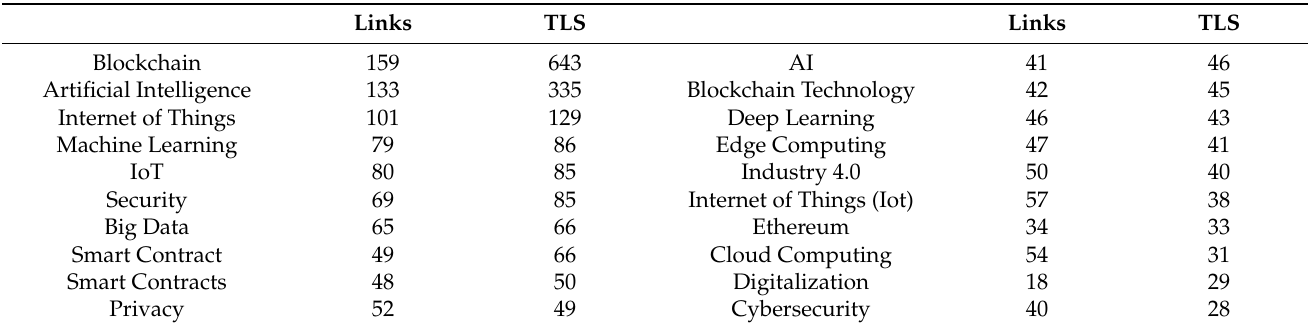
Table 9. Links and TLS for co-occurrence analysis (Top 20 author keywords).